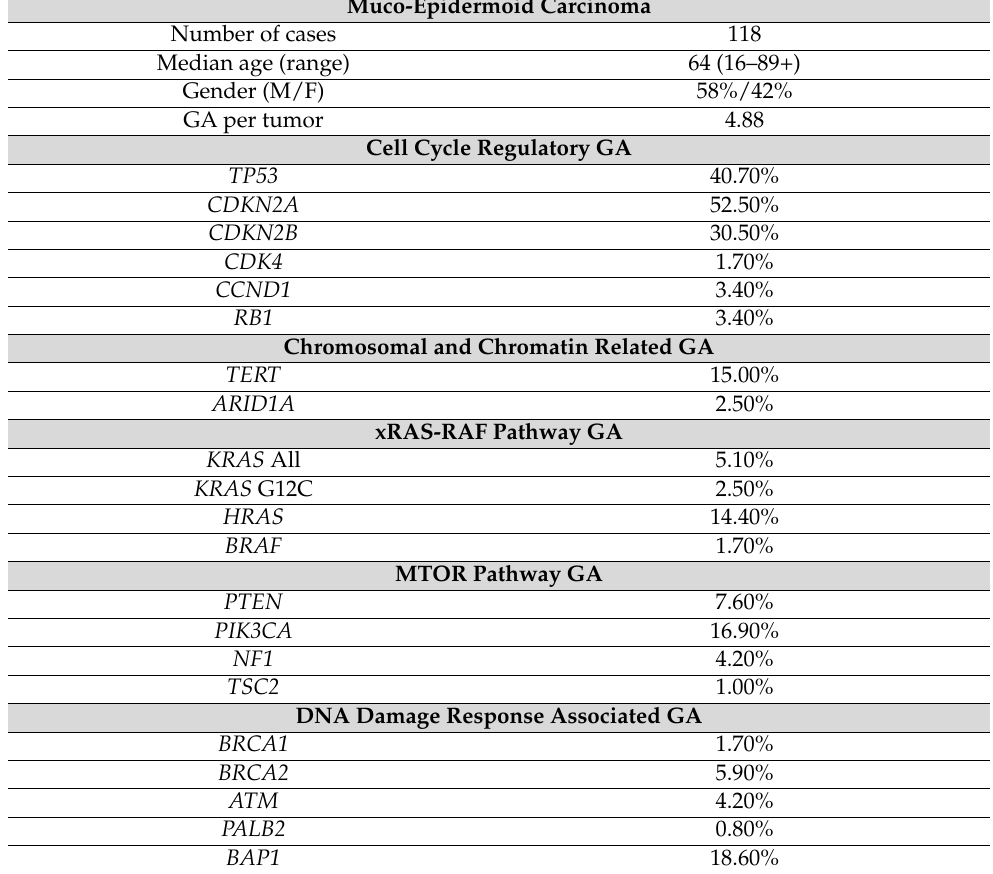
Table 1. Clinical characteristics and genomic alterations in